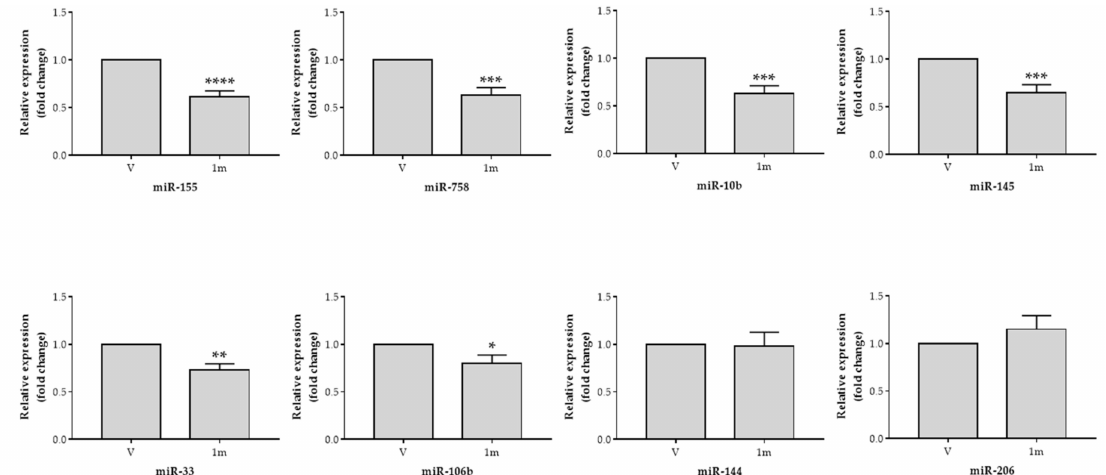
Figure 4. MicroRNAs were suppressed in THP-1 macrophages treated with chalcone 1m . THP-1 macrophages were incubated with a vehicle control (V) and 10 µ M of 1m for 24 h and were lysed for measuring the indicated microRNAs. The levels of specific microRNA (miR144, miR33, miR106b, miR155, miR758, miR145, miR10b, and miR206) were measured using qRT-PCR. Data are shown by the relative expressions of miRNA. (* p < 0.05, ** p < 0.01, *** p < 0.001, **** p < 0.0001 vs. vehicle control).